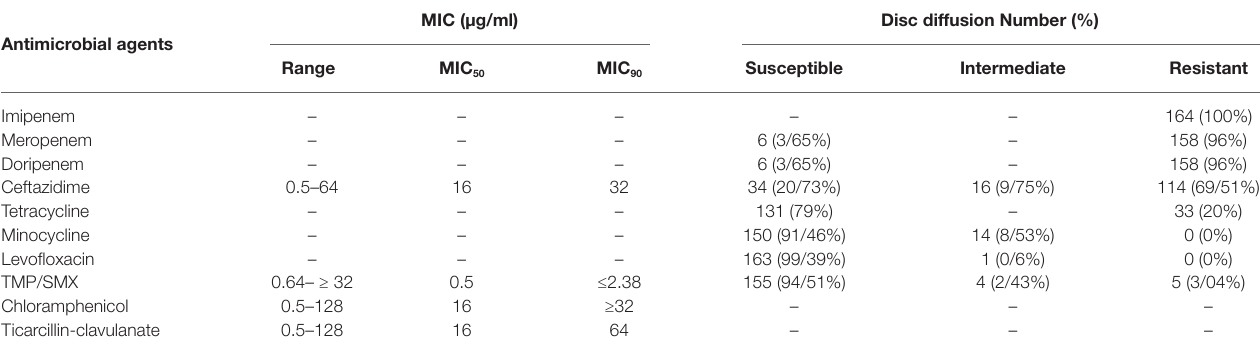
TABLE 2 | Antibiotic susceptibility of the S. maltophilia clinical isolates ( n = 164).